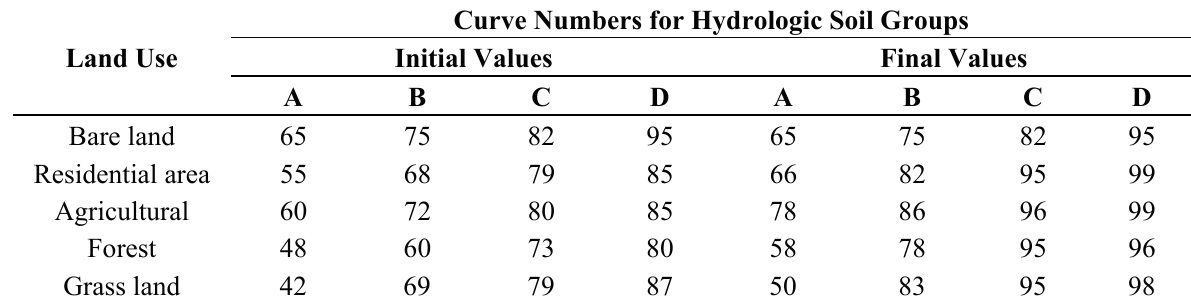
Table 3. Initial and final CN values for each land-use type.